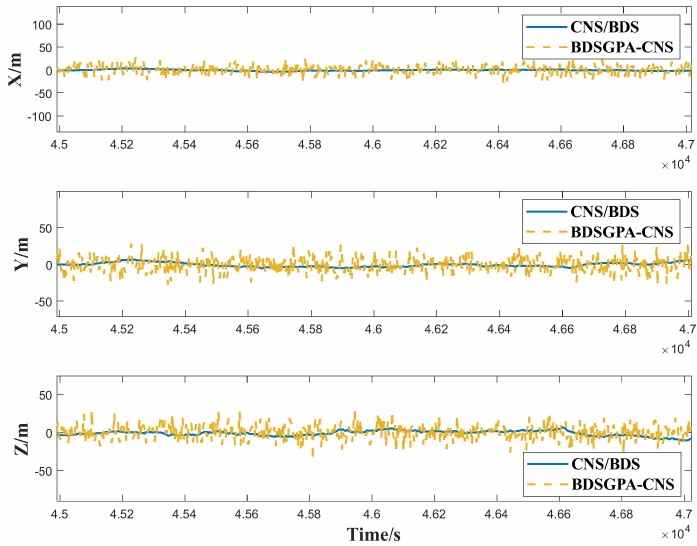
Figure 12. Local position error in three